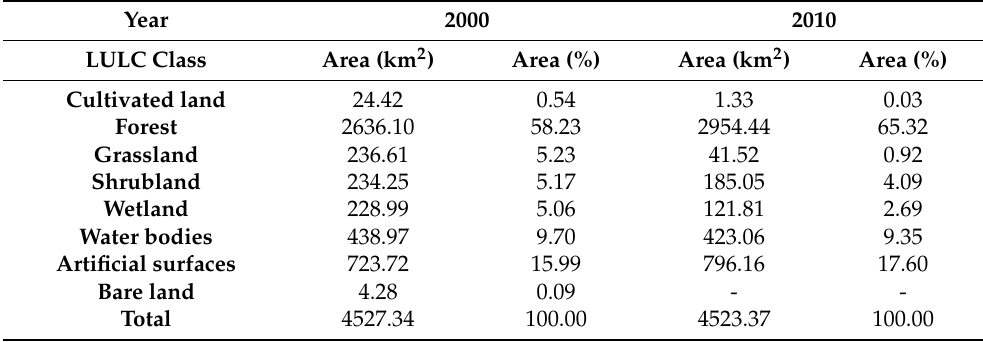
Table 4. Area statistics and number of changes in land use and land cover (LULC) during 2000 to 2010.